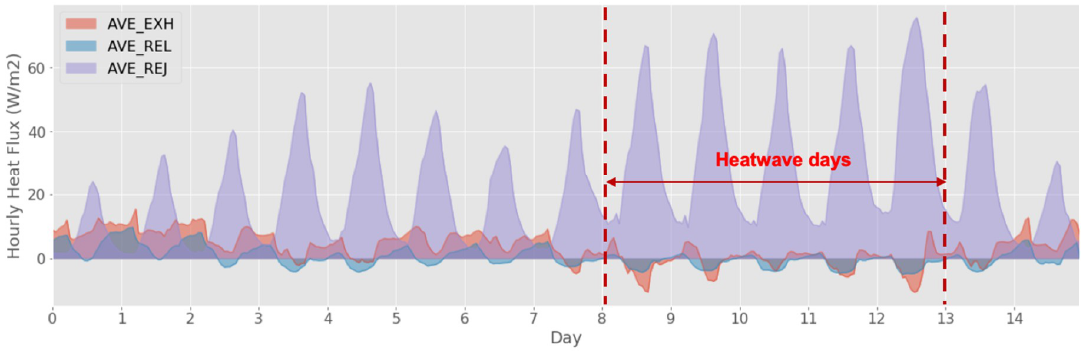
Figure 14. Component level of the hourly heat flux of the building waste heat.